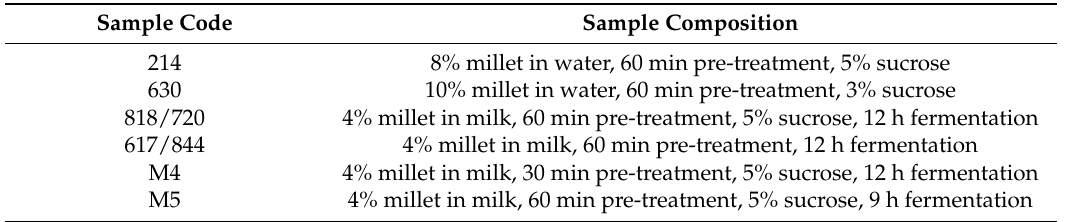
Table 4. Sample codes for sensory analysis.